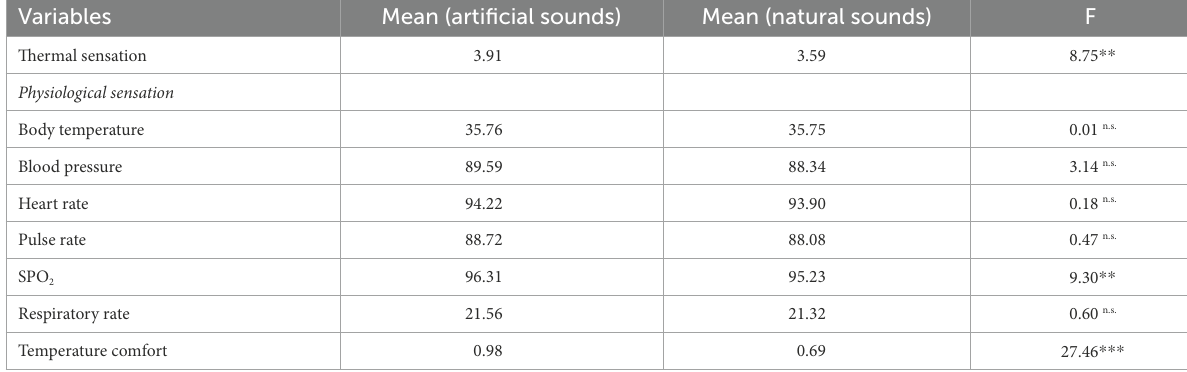
TABLE 4 Main effects of audio